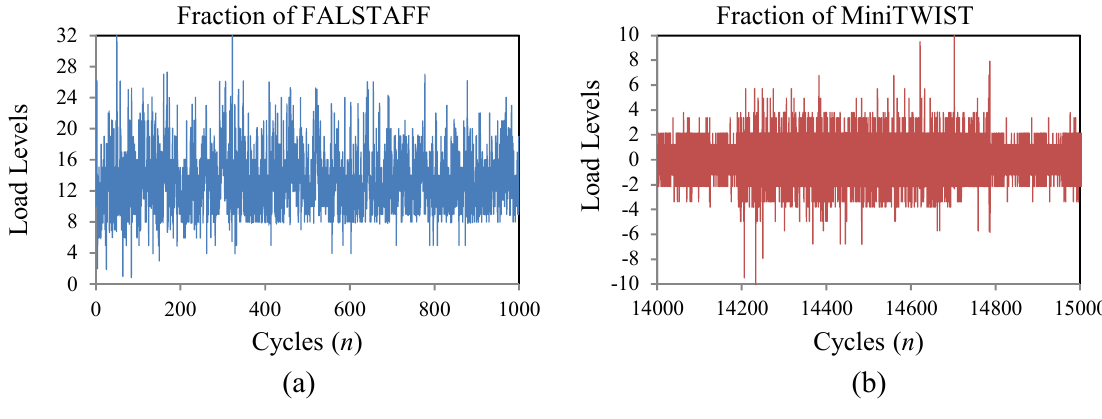
Figure 3. Fraction of the load sequences; ( a ) Fighter Aircraft—Falstaff; ( b ) Transport Aircraft—MiniTwist.